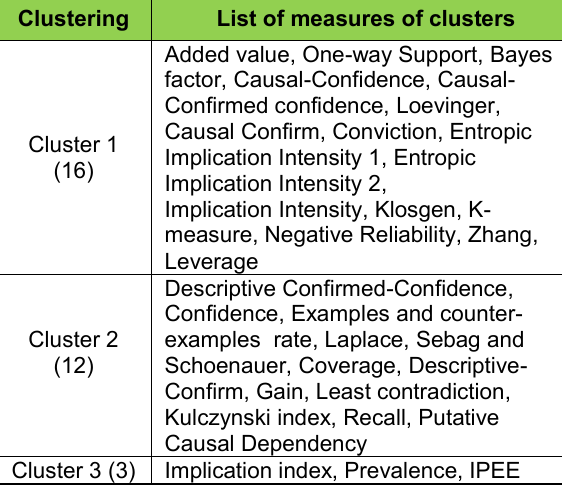
Table 5: The clustering results of measures based on Manhattan distance